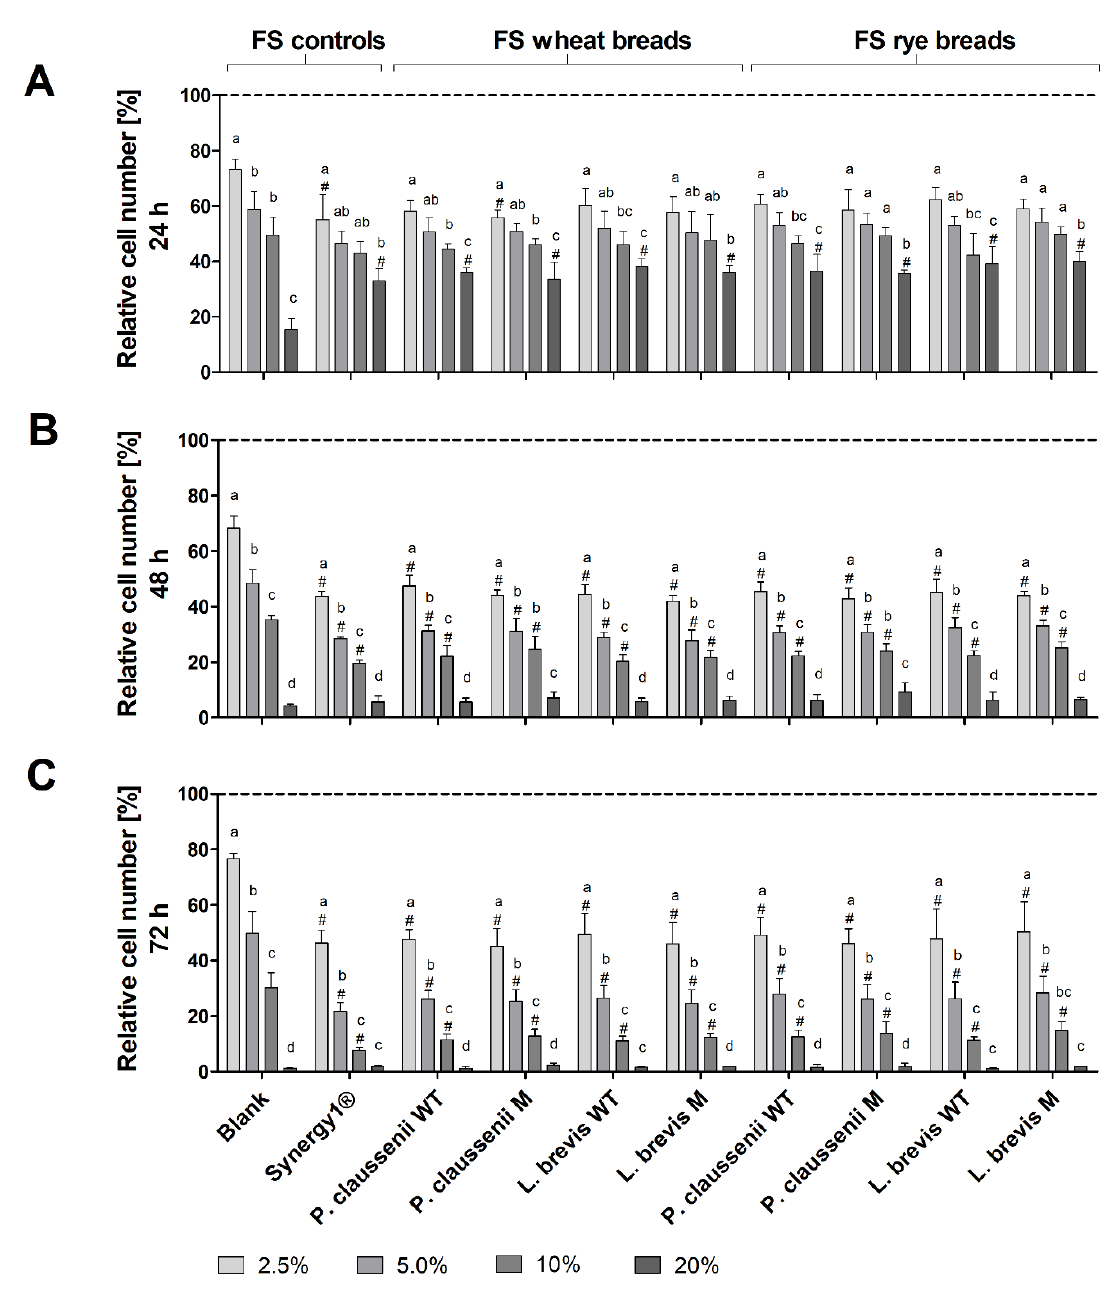
Figure 4. Relative number [%] of LT97 colon adenoma cells after treatment with different concen- trations (2.5%, 5%, 10% and 20%) of fermentation supernatants (FS) obtained from controls (blank, Synergy1 ® ) and wheat and rye breads for 24 h ( A ), 48 h ( B ) and 72 h ( C ). Breads were generated using wild-type (WT) and mutant (M) strains of Pediococcus claussenii (WT: TMW 2.340, M: TMW 2.2123) and Levilactobacillus brevis (WT: TMW 1.2112, M: TMW 1.2320). Results were calculated on the basis of the medium control (dashed line), which was set at 100% (mean + SD, n = 3). Significant differences between cells treated with FS blank and cells treated with FS of all other samples ( # p < 0.05) and significant differences between cells treated with different concentrations of FS ( a–d p < 0.05, different letters represent significantly different results) were obtained by one-way ANOVA and F-test according to Ryan–Einot–Gabriel–Welsh. TMW: Technische Mikrobiologie Weihenstephan.